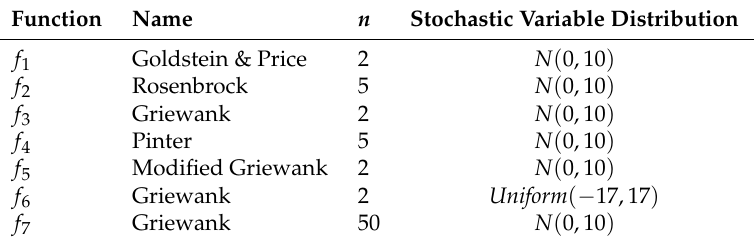
Table 3. Stochastic programming test